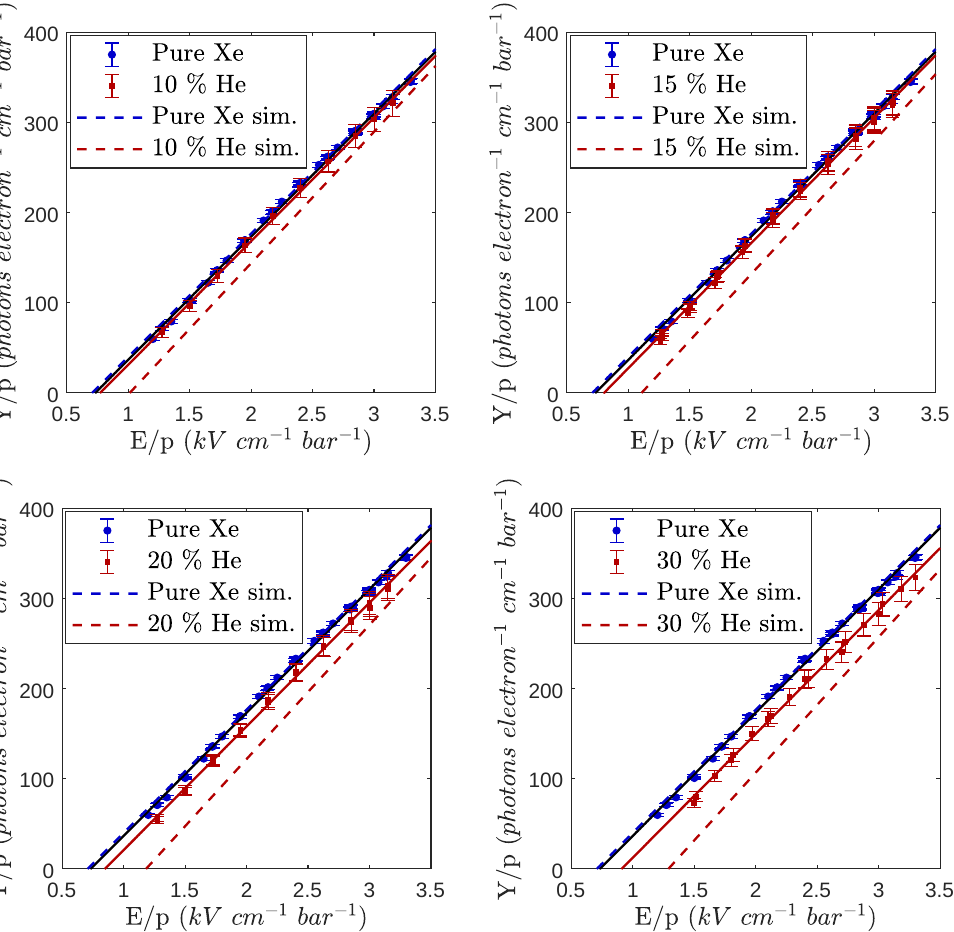
Figure 8 . Reduced electroluminescence yield as a function of reduced electric (cid:12)eld in the EL region for pure xenon and the di(cid:11)erent Xe-He mixtures studied in this work. Solid lines show linear (cid:12)ts to the experimental data, while dashed lines are the simulation data obtained with the simulation tool of ref.